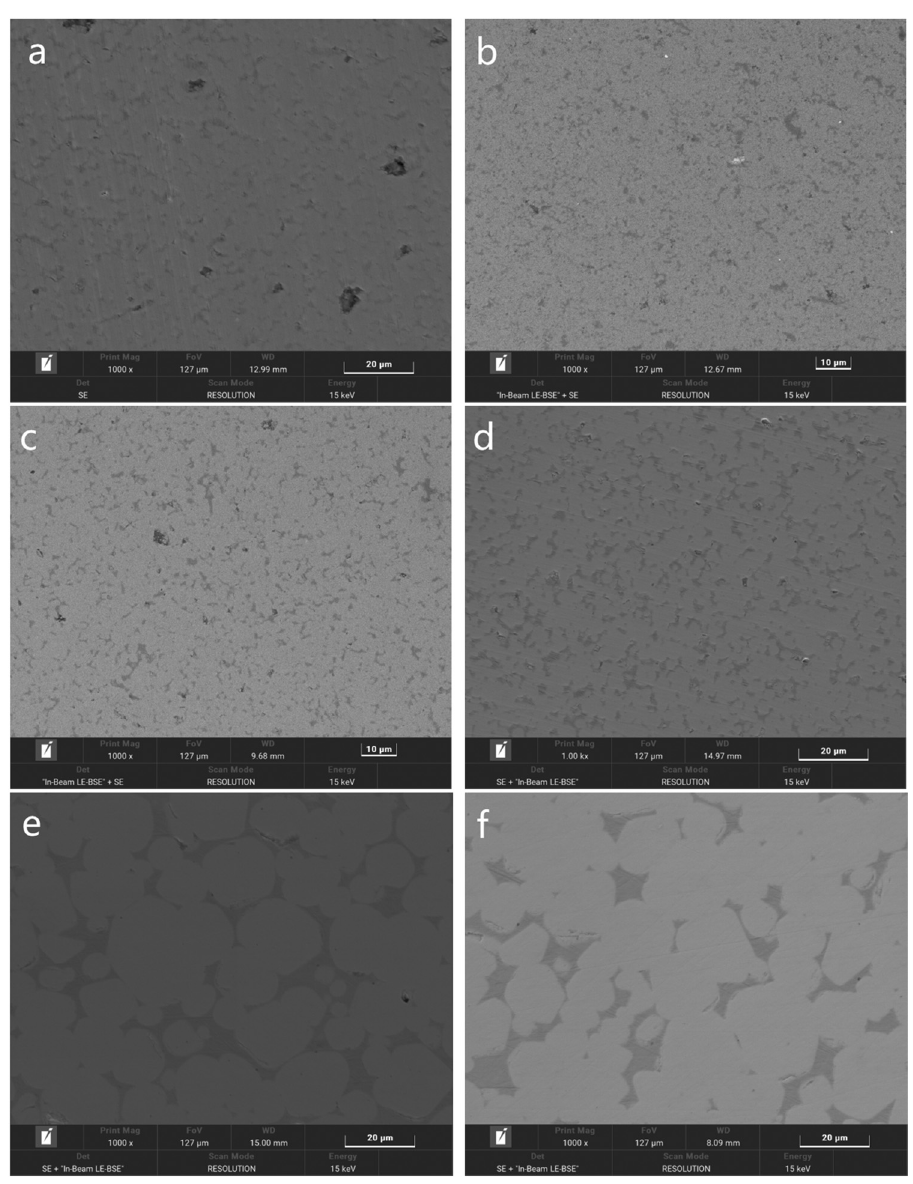
Figure 2: SEM micrograph ( s ) of NbC – 12Ni cermets with di ff erent sintering temperatures ( SE + BSE mode ) : ( a ) 1,270°C, ( b ) 1,300°C, ( c ) 1,330°C, ( d ) 1,390°C, ( e ) 1,420°C, and ( f ) 1,450°C, and dwell time 15 min